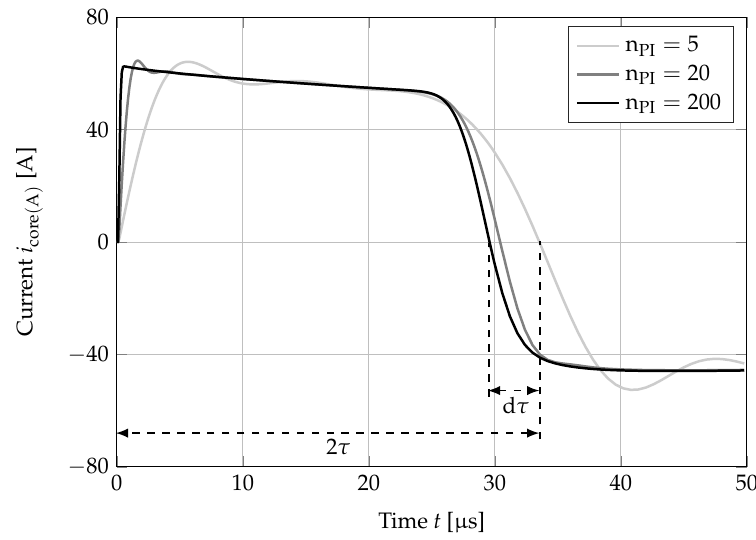
Figure 10. Simulations of the discharge current with different number of PI-sections.